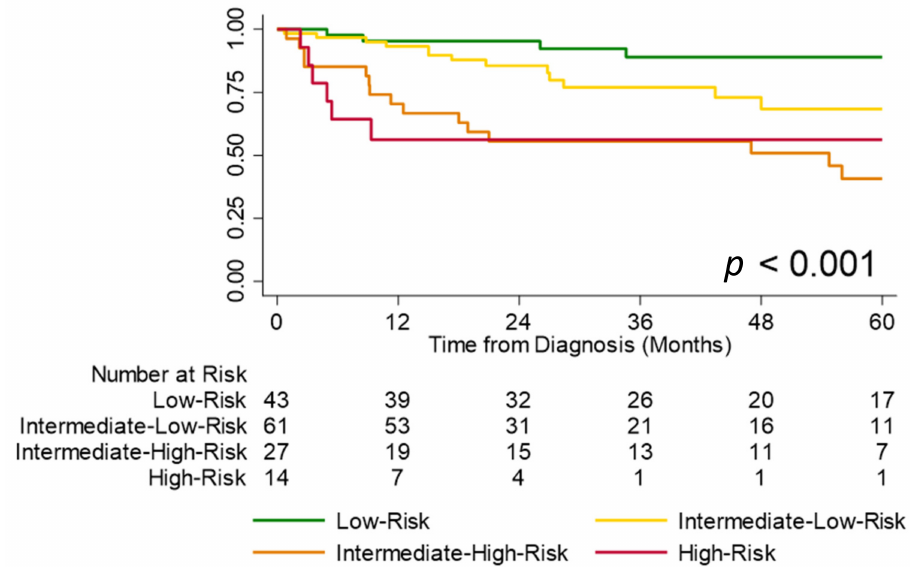
Figure 3. Transplant-free survival by risk group (low vs. intermediate-low vs. intermediate-high vs. high) using degree of tricuspid regurgitation (TR) to further stratify intermediate-risk patients. Note: One intermediate-risk patient missed their degree of TR and was not included in the